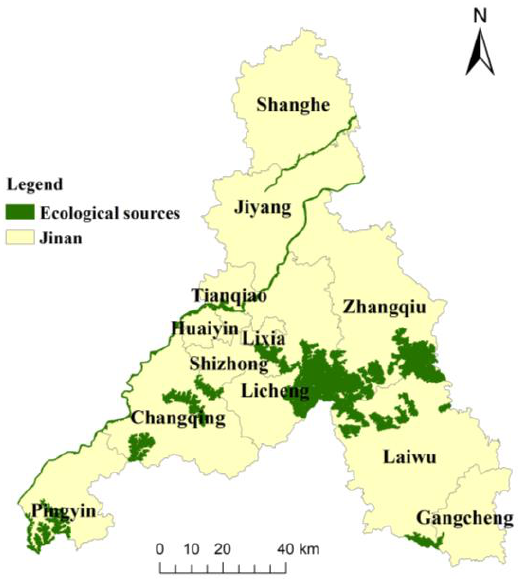
Figure 7. Ecological sources in the study area.